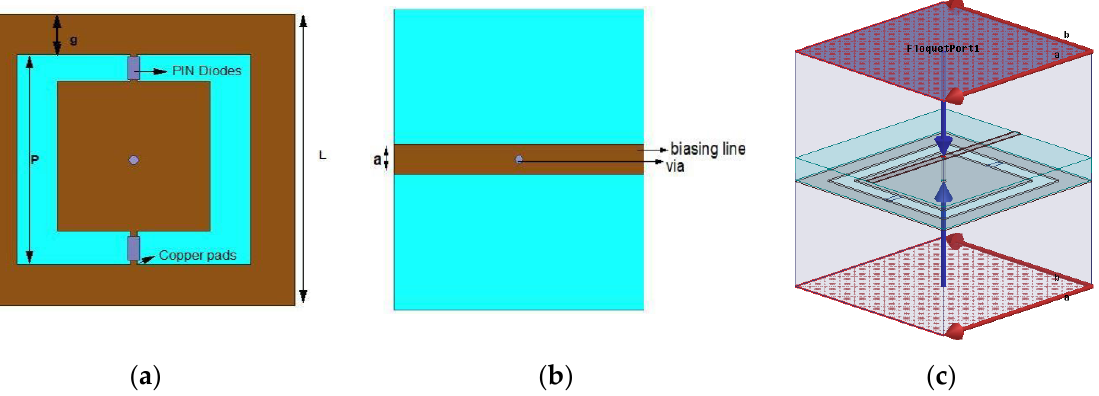
Figure 3. The conceptual design of unit cell ( a ) Front-view and ( b ) Back-view ( c ) Unit cell with view with Floquet Ports.